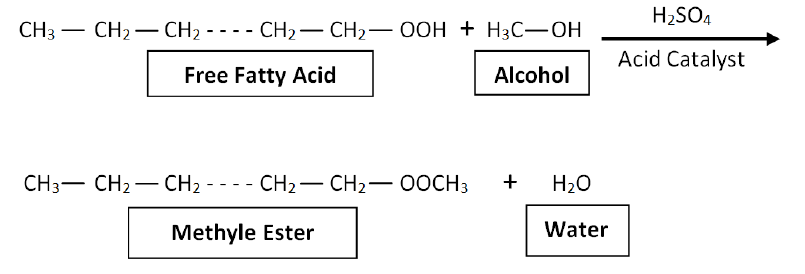
Figure 4. Acid pre-esterification [60].